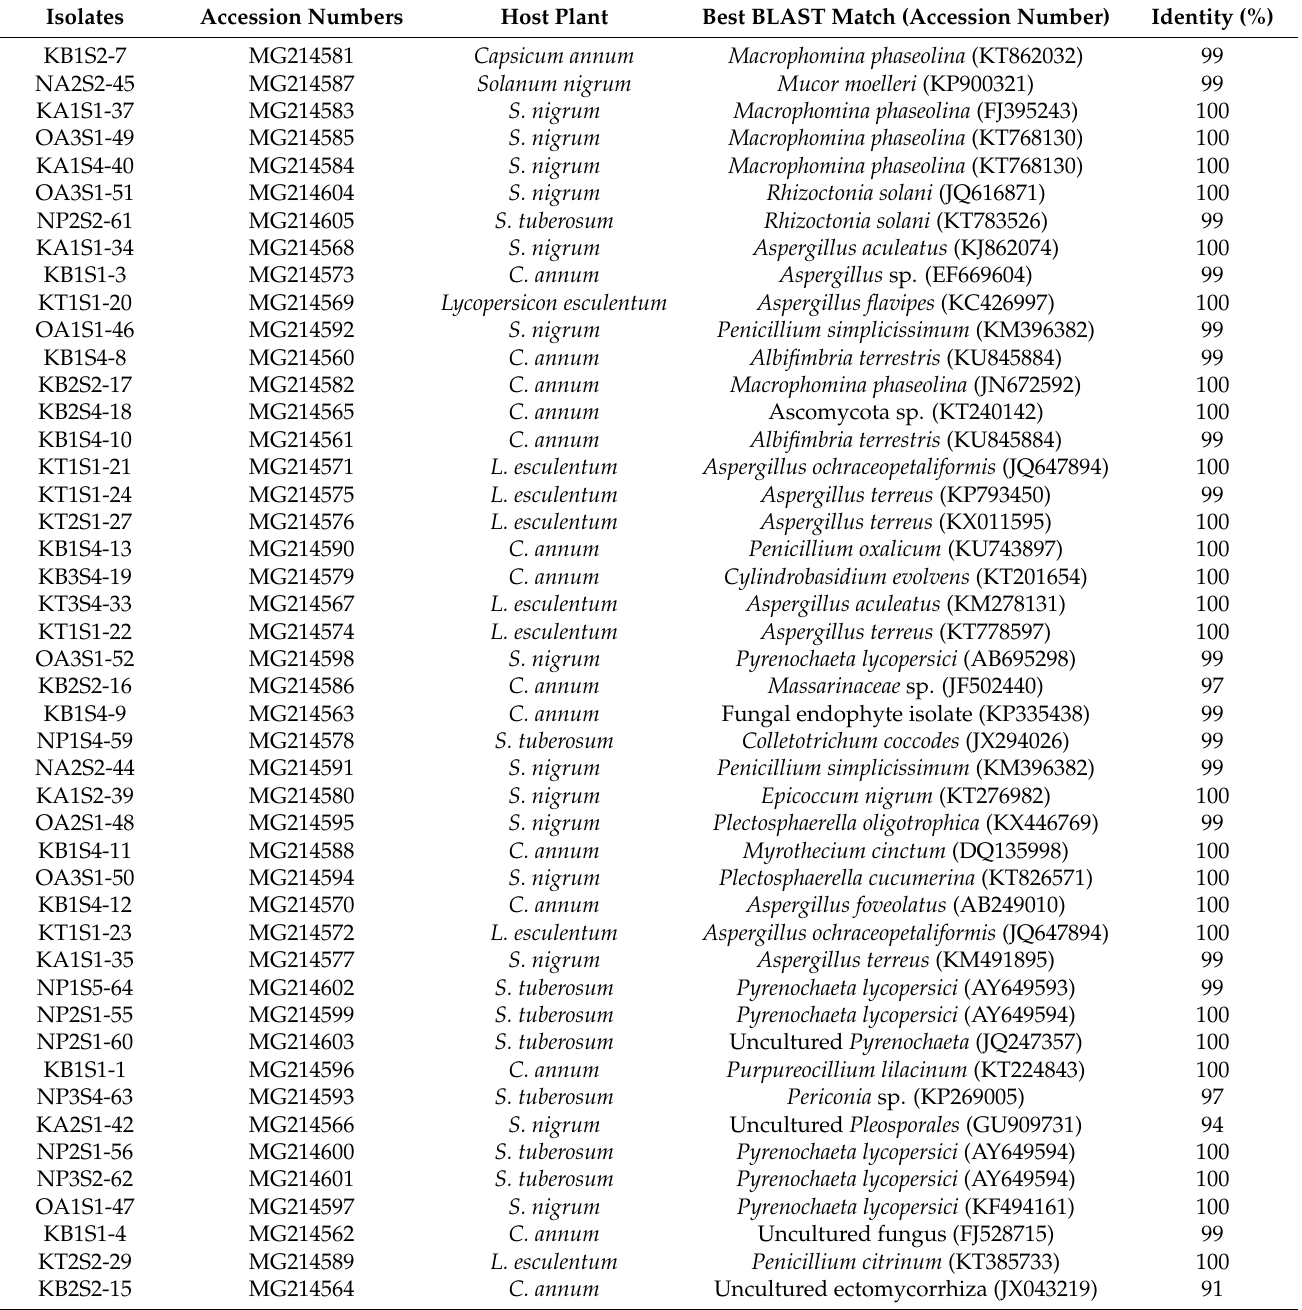
Table 1. Molecular identity of endophytic fungi from four solanaceous